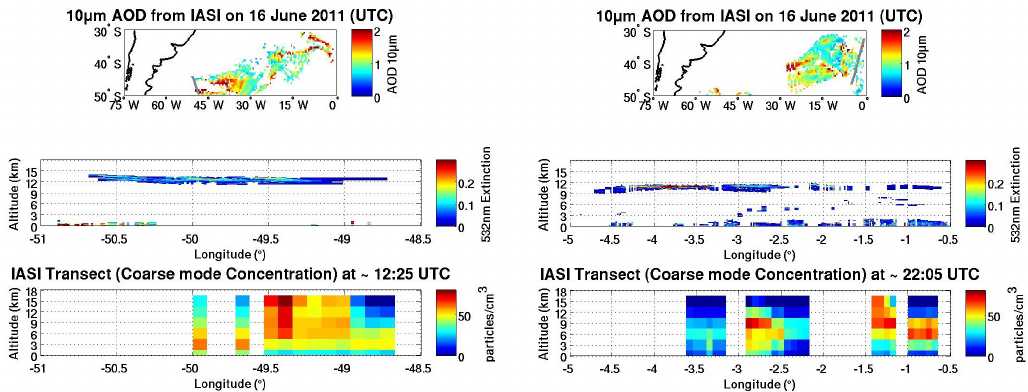
Figure 11. Comparison between CALIOP transects (middle panel) across the ash plume on 16 June 2011 and the IASI retrievals along those transects (lower panel). The optical depths are also shown in the upper panel. The left part concerns day-time data, while the right part concerns night-time